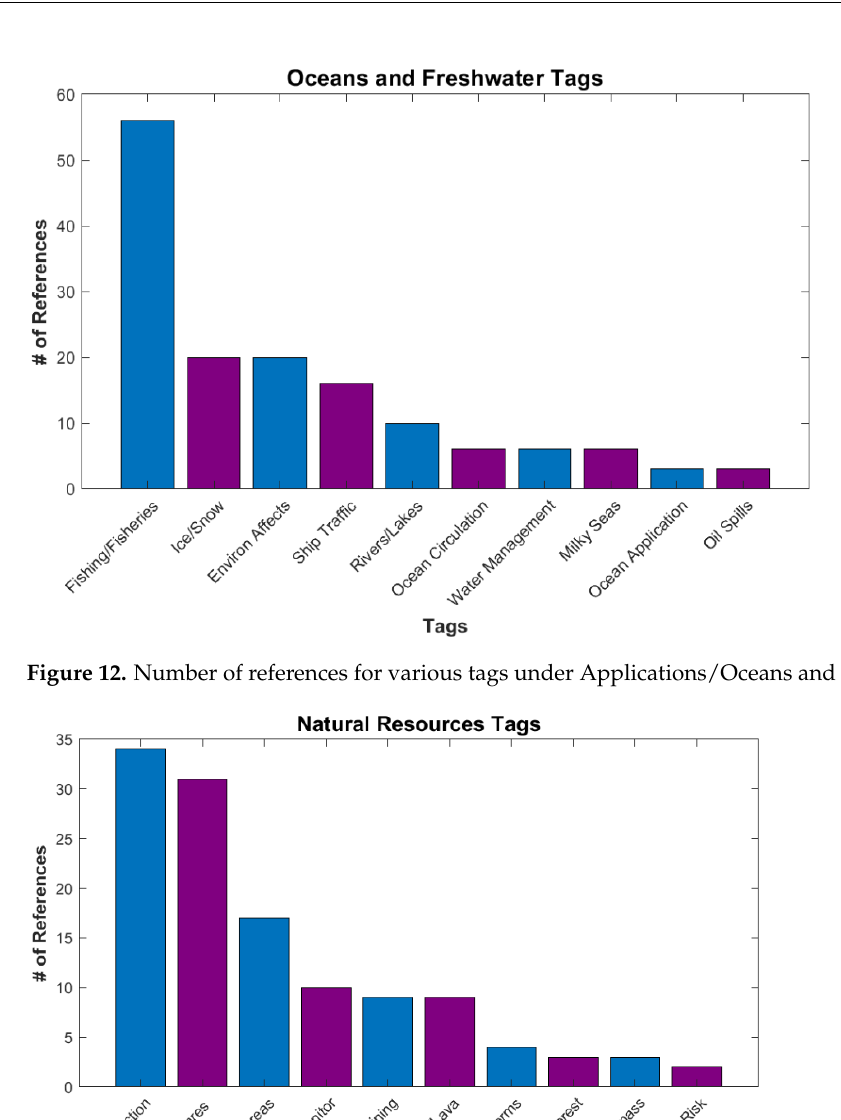
12 of 24 Figure 11. Number of references for various tags under Applications/Biology. 3.2.7. Oceans and Freshwater Oceans and Freshwater, with 84 references, include applications that involve water resources (Figure 12). Fishing is a large tag in this category. The DNB can detect the lights associated with night fishing, which can be used to monitor the number and locations of